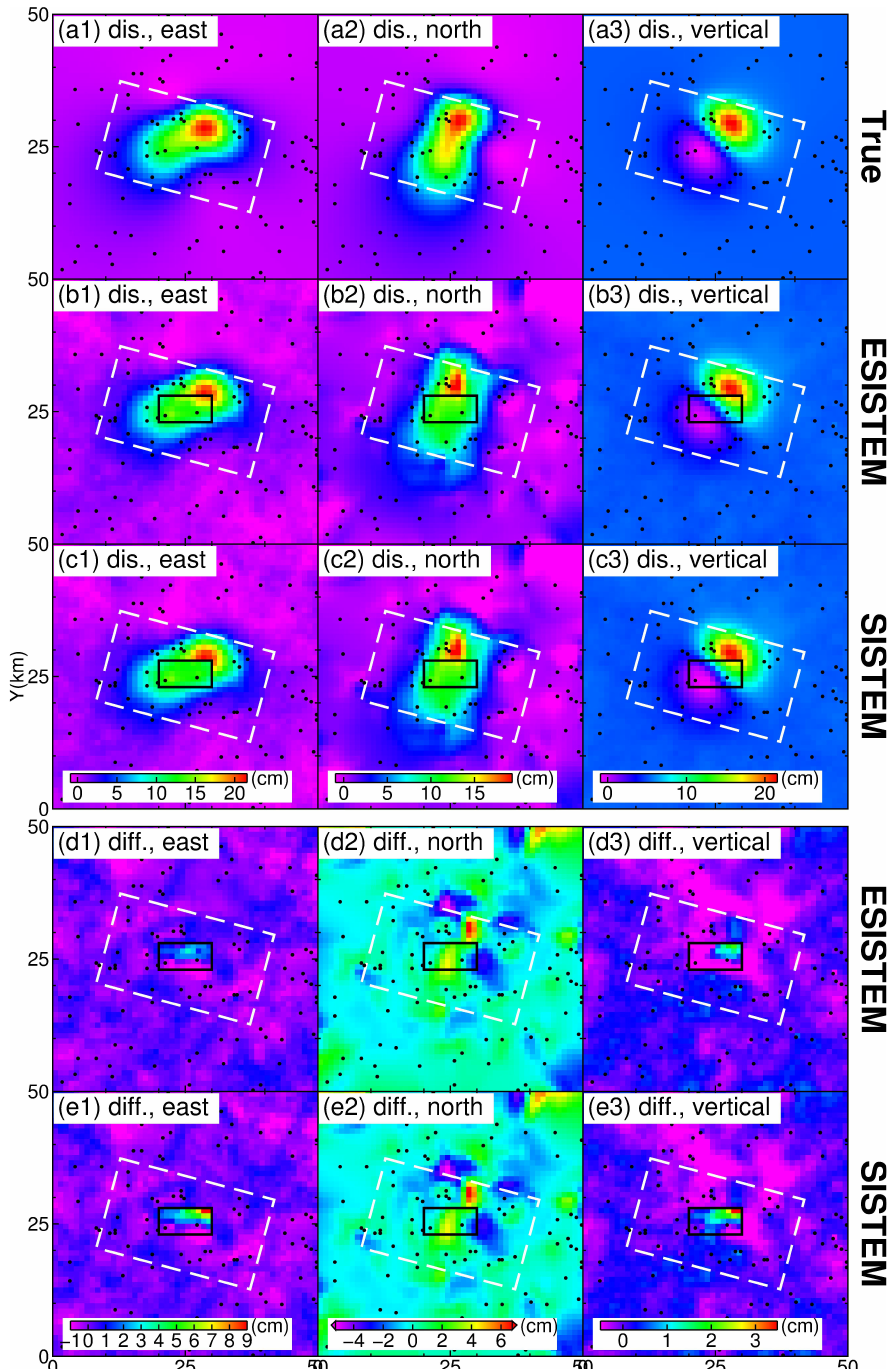
Figure 2. Solutions of ESISTEM and SISTEM approaches for synthetic tests: ( a1 – a3 ) three-dimensional surface displacement fields from fault slip shown in Figure S1 with elastic dislocation theory [20], termed true displacement fields; ( b1 – b3 ) modeled three-dimensional surface displacement fields for east, north and vertical components, respectively, from an integration of InSAR (shown in Figure S1) and GPS data (black dots) using ESISTEM approach; ( c1 – c3 ) modeled displacement fields from an integration of InSAR and GPS data using SISTEM approach; ( d1 – d3 ) differences between ESISTEM-derived and true displacements; and ( e1 – e3 ) differences between SISTEM-derived and true displacements. The rectangle (black line) covers the region lacking InSAR LOS data from ascending track, and the dashed rectangle the region of fault plane projected onto